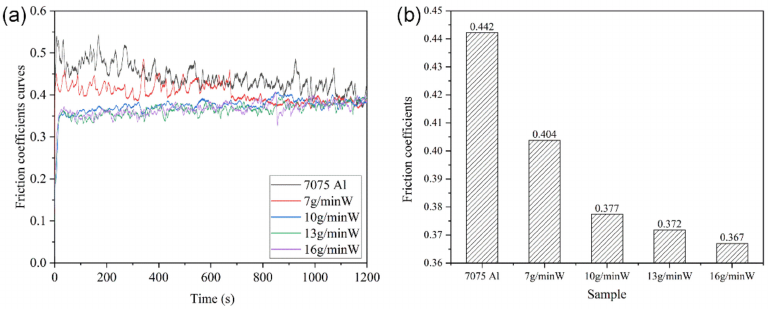
Figure 10. ( a ) Friction coefficient curves and ( b ) average friction coefficients of the W/Al composite layers and 7075 Al substrate.